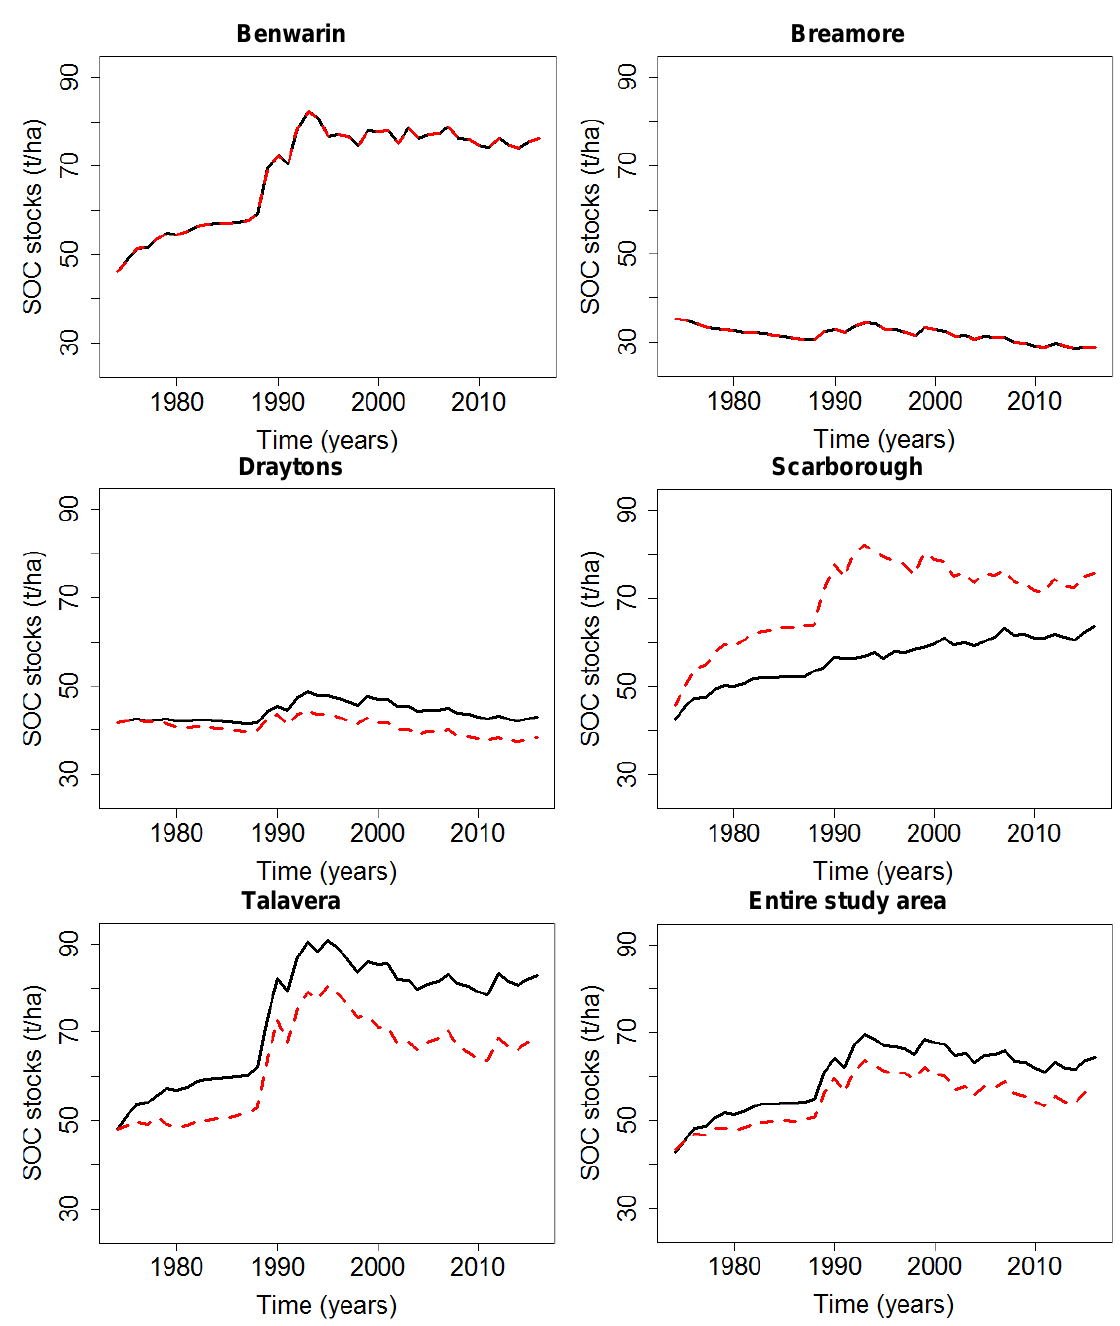
Figure 6. The simulated effect of soil redistribution on mean SOC stocks in the 0–100 cm in five fields and the entire study area for the 1970s–2016 period. Red line is with soil redistribution and black